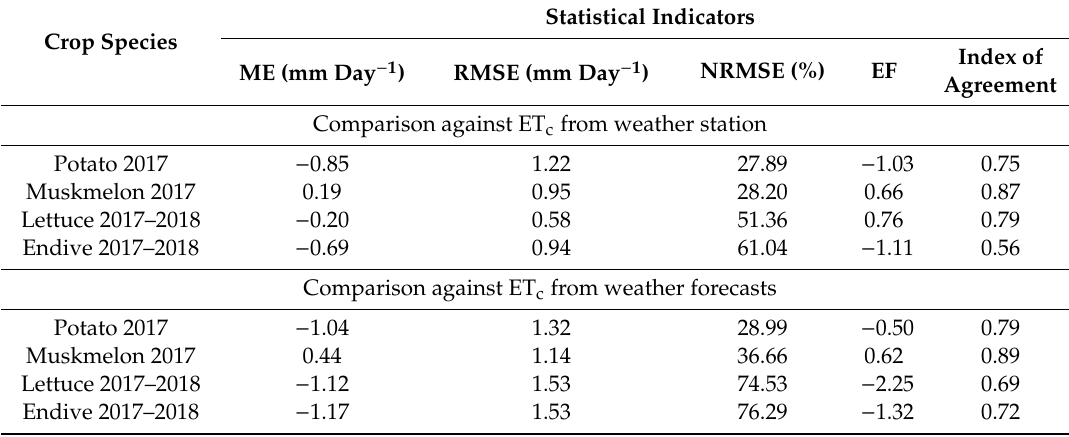
Table 2. Statistical indicators of model performance for the crop species studied. Abbreviations: ME = mean bias error; RMSE = root-mean-squared error; NRMSE = normalized root-mean-squared error; EF = modeling e ffi